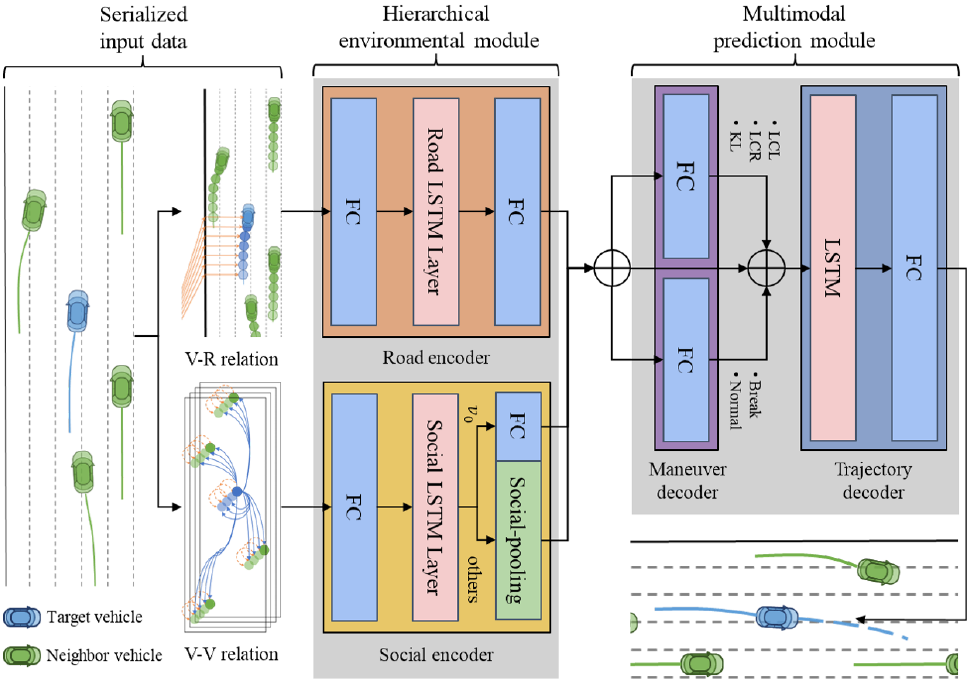
Figure 2. Architecture of the proposed vehicle trajectory prediction model for learning vehicle–road relationships and vehicle–vehicle relationships in highway